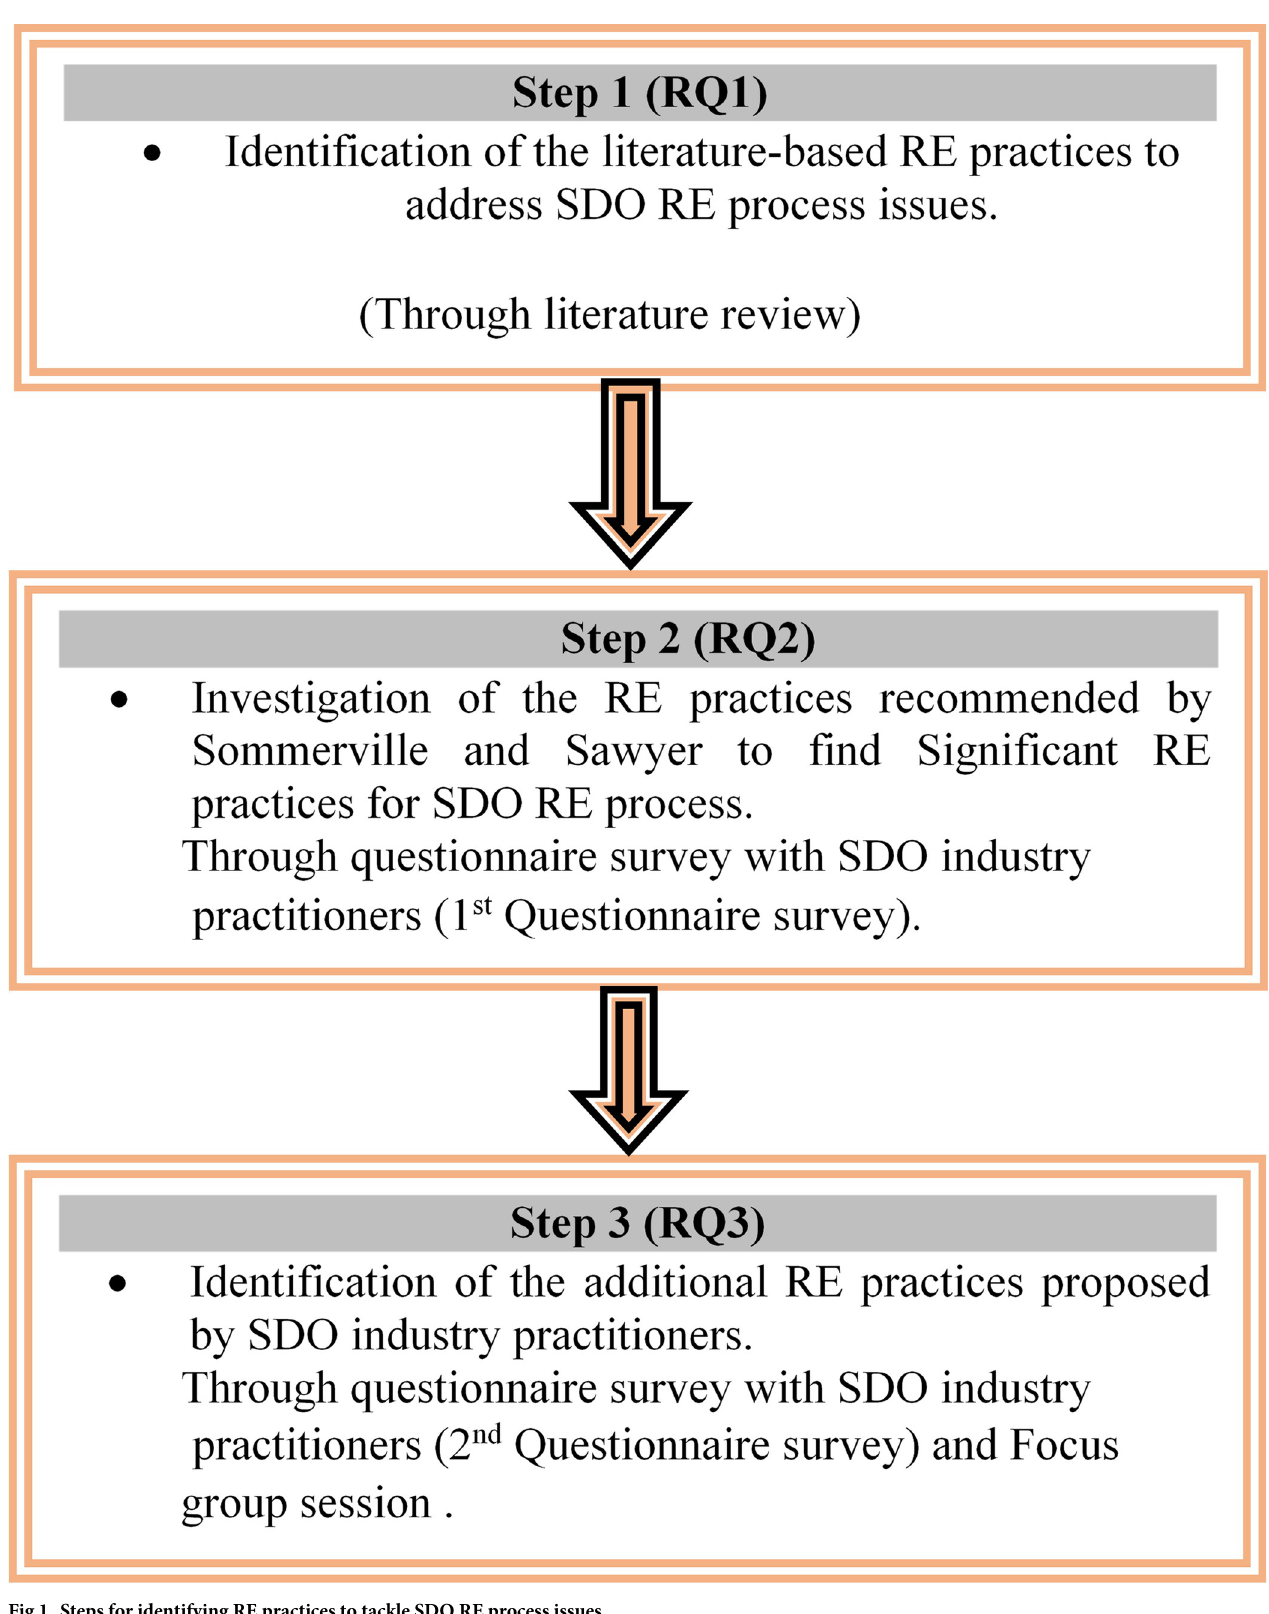
Fig 1. Steps for identifying RE practices to tackle SDO RE process issues. https://doi.org/10.1371/journal.pone.0269607.g001 PLOS ONE | https://doi.org/10.1371/journal.pone.0269607 July 14,